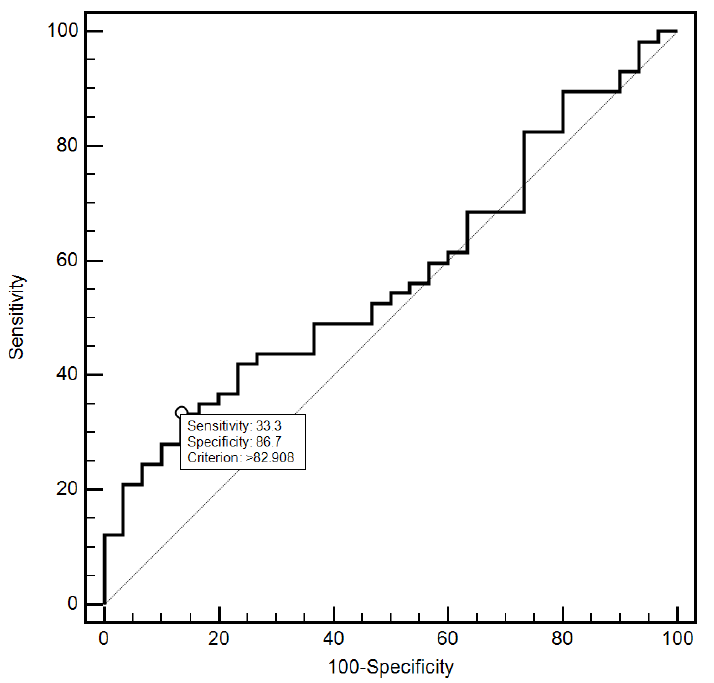
Figure 10. Assessment of the diagnostic usefulness of the MMP-8 (ng/mL) concentration determina- tion in the peripheral blood serum in the early detection of preterm labor using the ROC